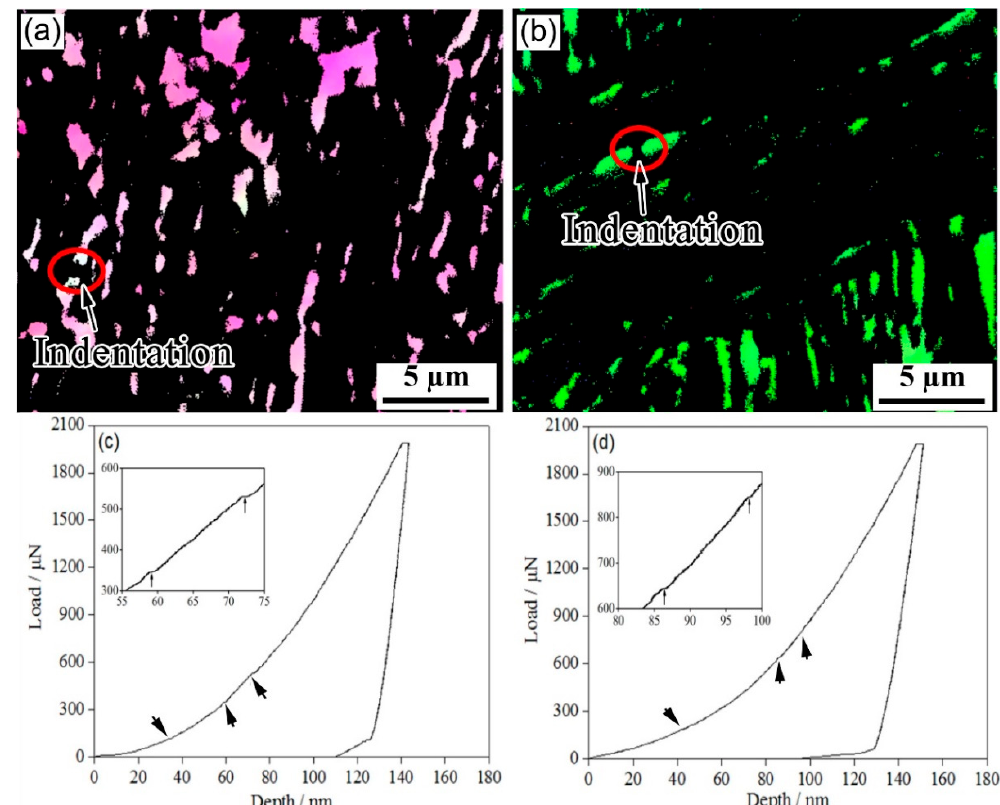
Figure 7. Nanoindentation of RA film in the investigated steel for ( a , c ) one-step and ( b , d ) two-step techniques. ( a , b ) FCC structures and ( c , d ) representative load–displacement plots. Table 2. Nanohardnesses of the different phases for the investigated steel (GPa).